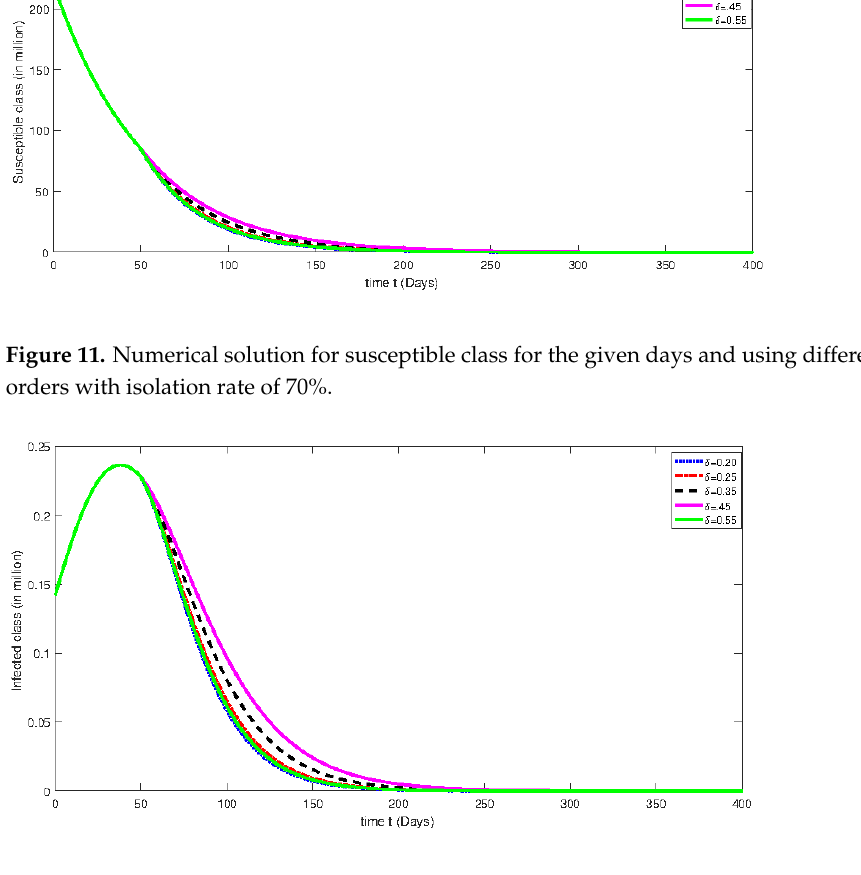
Figure 12. Numerical solution for infected class for the given days and using different fractional orders with isolation rate of